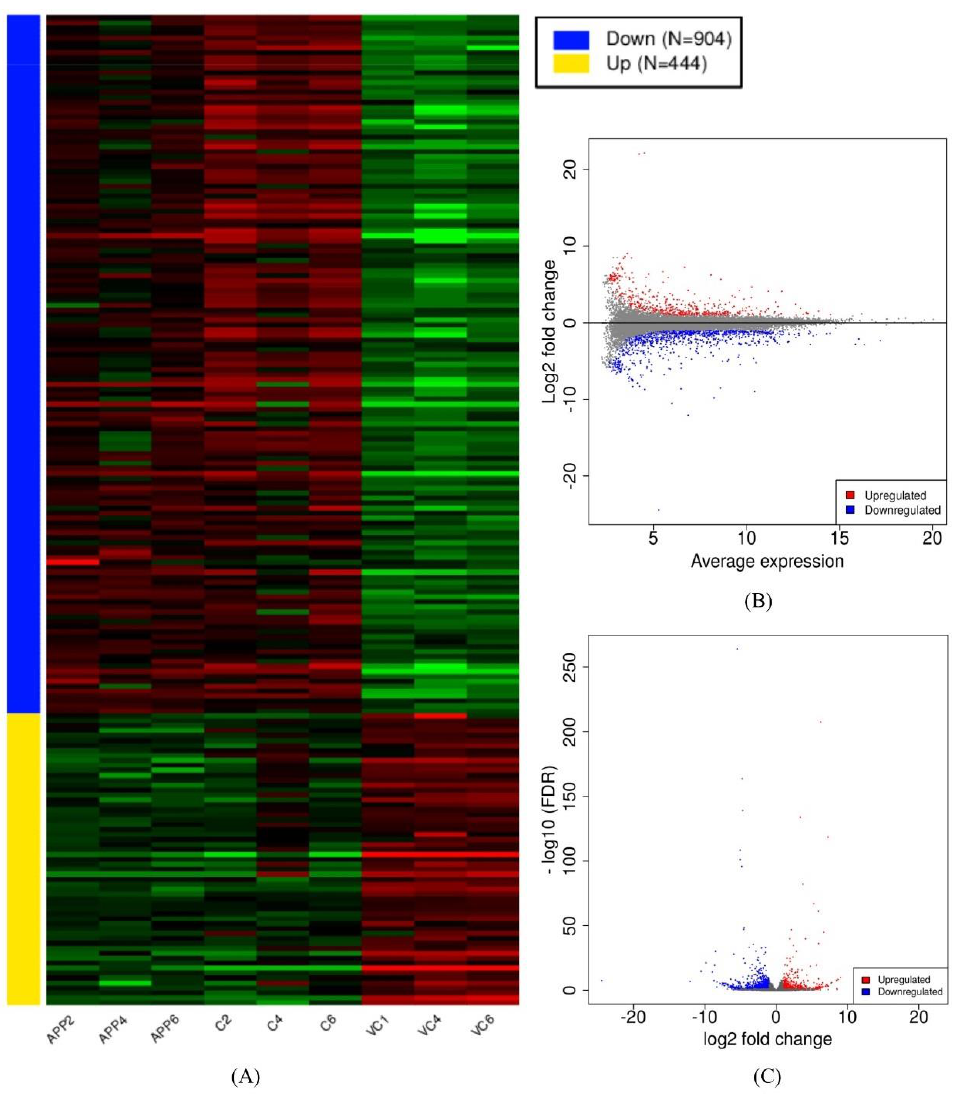
Figure 1. ( A ) Heatmap, ( B ) MA, and ( C ) volcano plots of differentially expressed genes (DEGs) in the comparison of Wt mice vs. ADM mice.